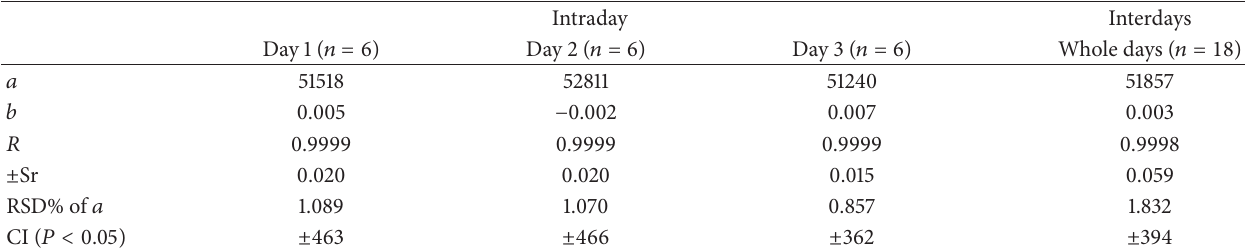
Table 2: Calibration data for PIR.